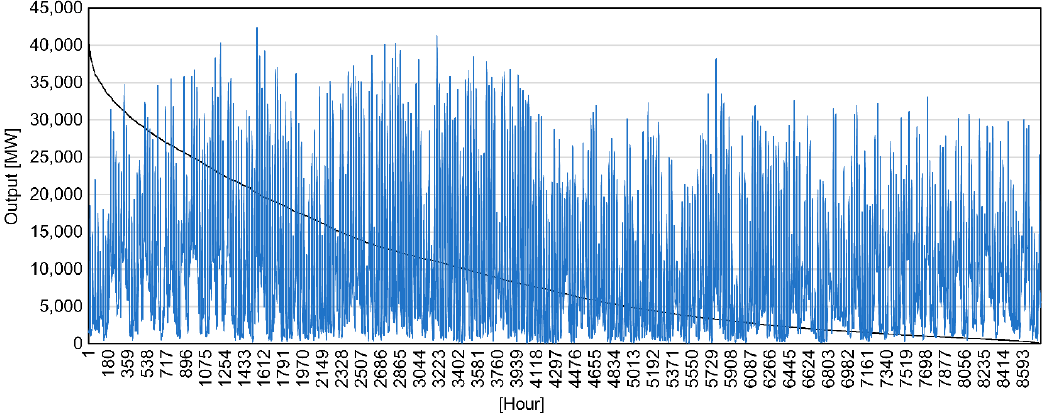
Figure 1. Output and duration curve of VRE for 2030.